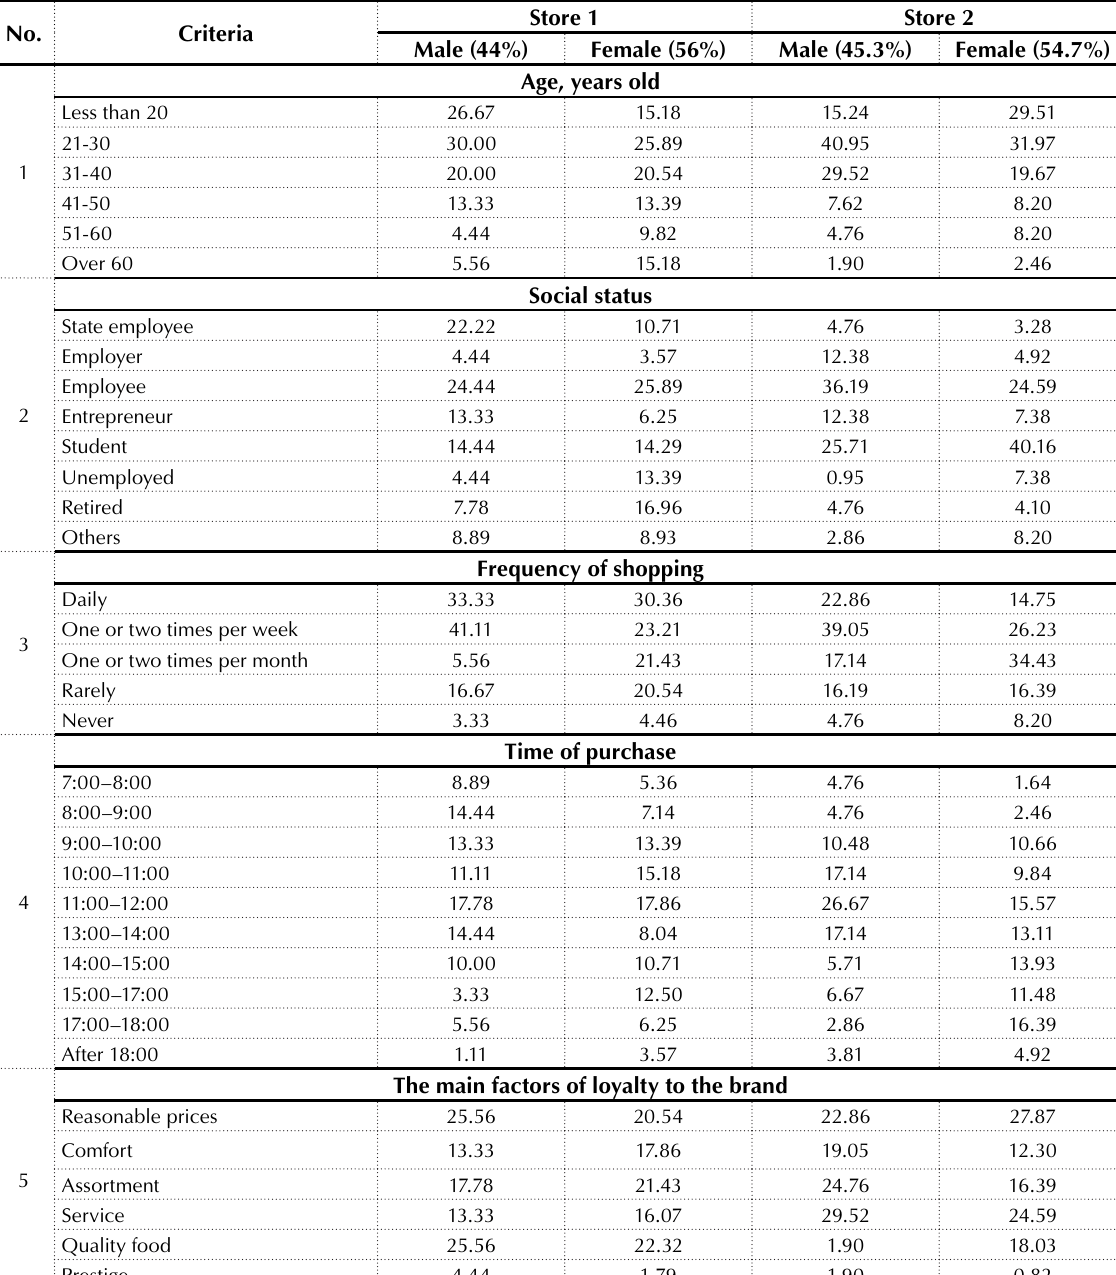
Source: Compiled by the authors according to consumer